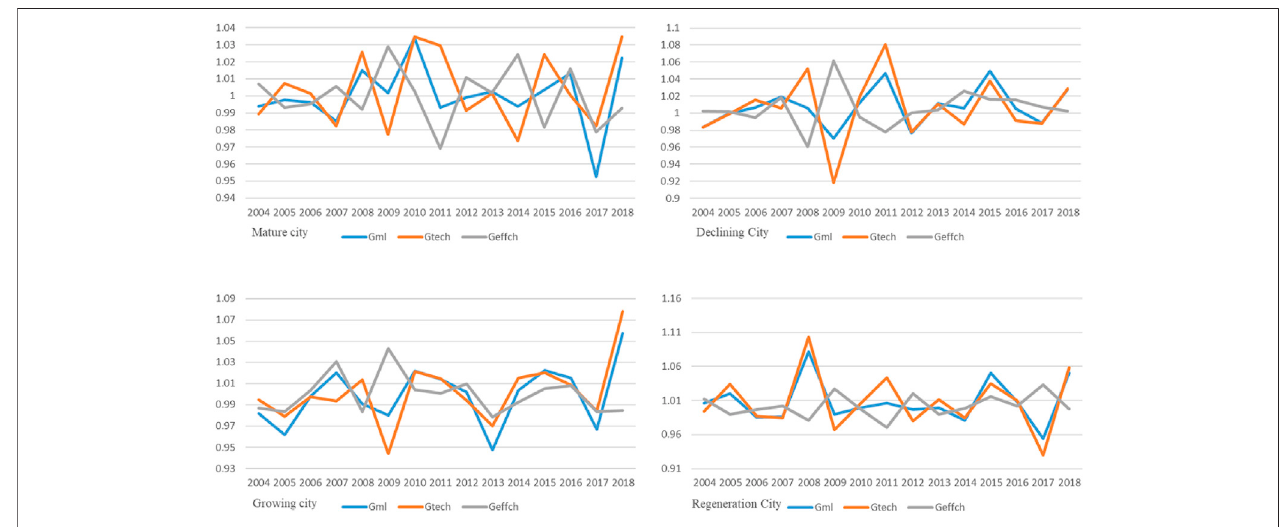
FIGURE 6 | The GML, Gtech, and Geffch indexes of four resource-based cities with different life cycles from 2004 to 2018.